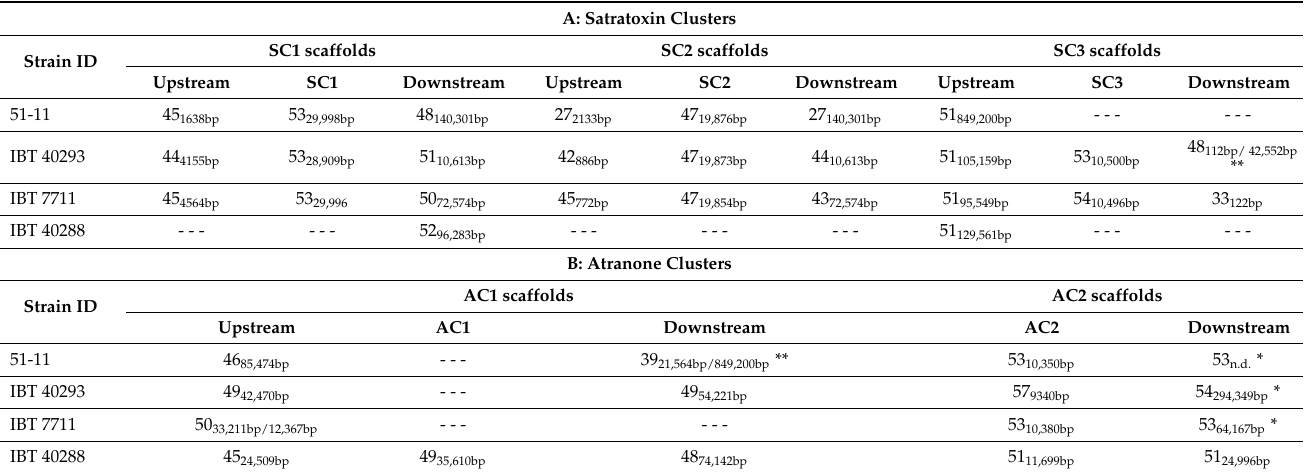
Table 3. ( A , B ): Comparison of the genomic G+C content of the SC and AC and their up- and downstream regions of strains 51-11, IBT 40293, IBT 7711, and IBT 40288. The GC content (in %) is given in normal-sized numbers; the length of the respective sequence is given in subscript. Bp, base pairs; n.d., not determined; - - -, missing. * fragments present in different scaffolds; ** sequence divided into two parts residing in different